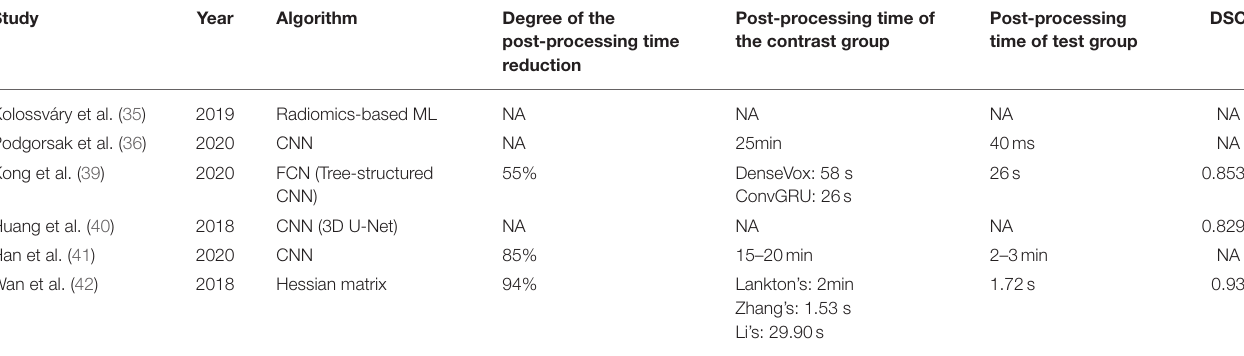
TABLE 3 | Application of artificial intelligence for image segmentation in